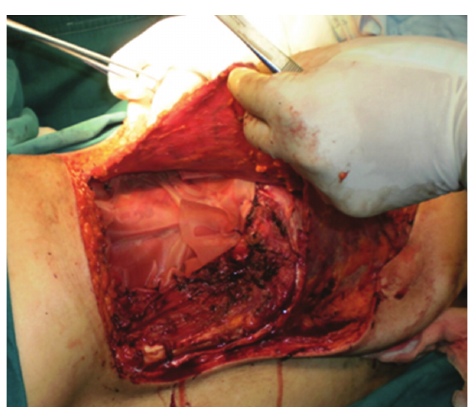
Figure 8: Mersilene mesh being